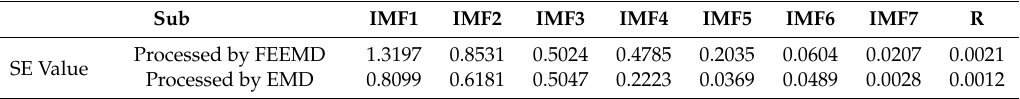
Table A2. The results on the SE values of the Hubei carbon price